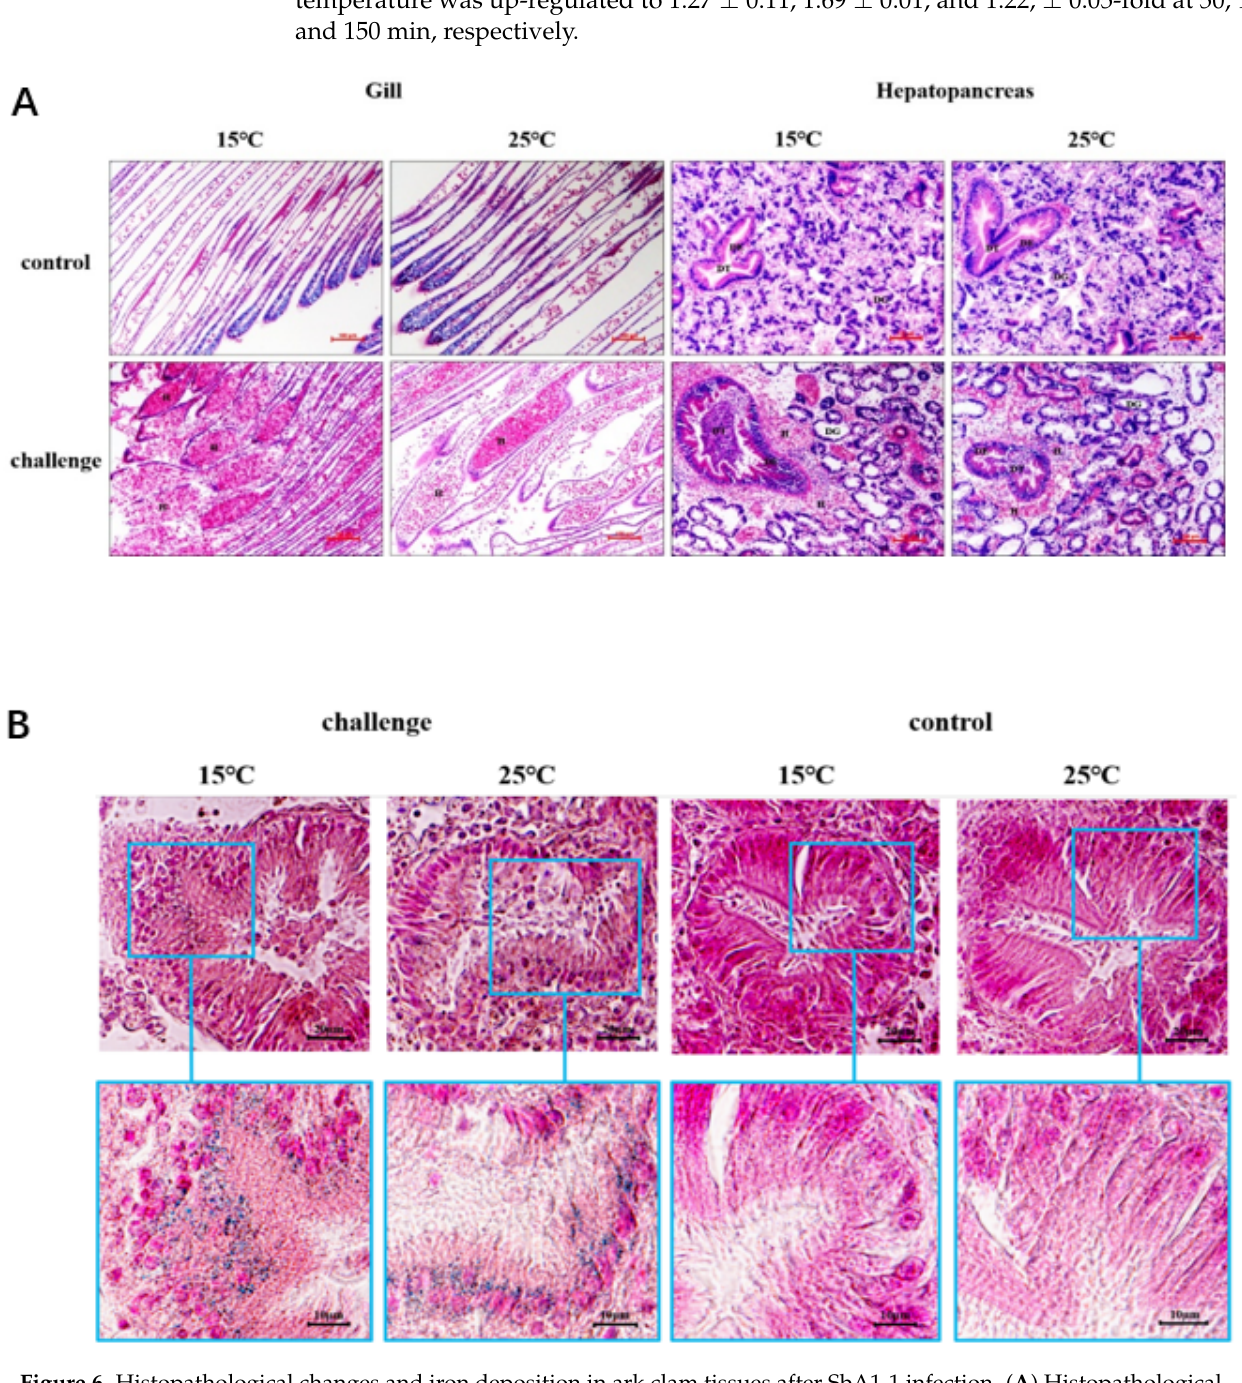
Figure 6. Histopathological changes and iron deposition in ark clam tissues after SbA1-1 infection. ( A ) Histopathological changes in gill and hepatopancreas tissues. Bar = 100 μ m. ( B ) Iron deposition in the hepatopancreas showed by Prussian blue stain. H, hemocyte; DE, digestive epithelium; DT, digestive tubule; DG, digestive gland.